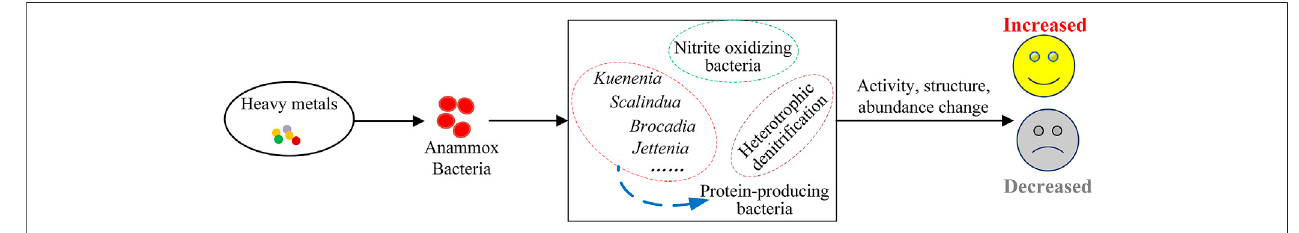
FIGURE 2 | Effects of heavy metals on the microbial